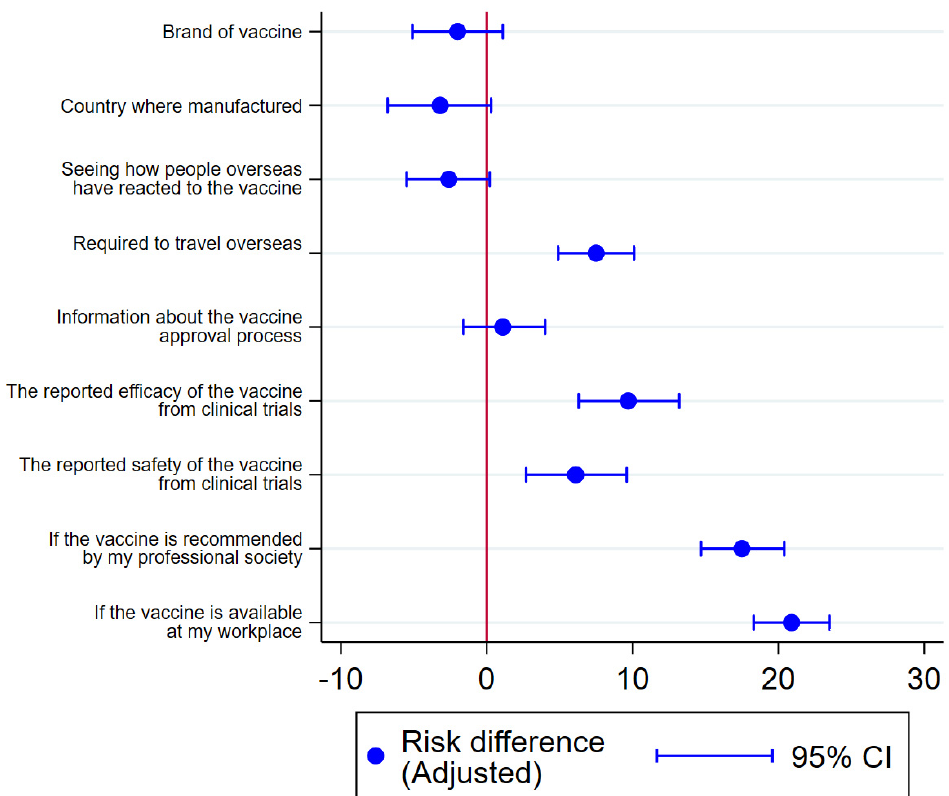
Figure 2. Factors associated with intention to accept a COVID-19 vaccine. Risk difference adjusted for age, sex, CALD, employment and remoteness.